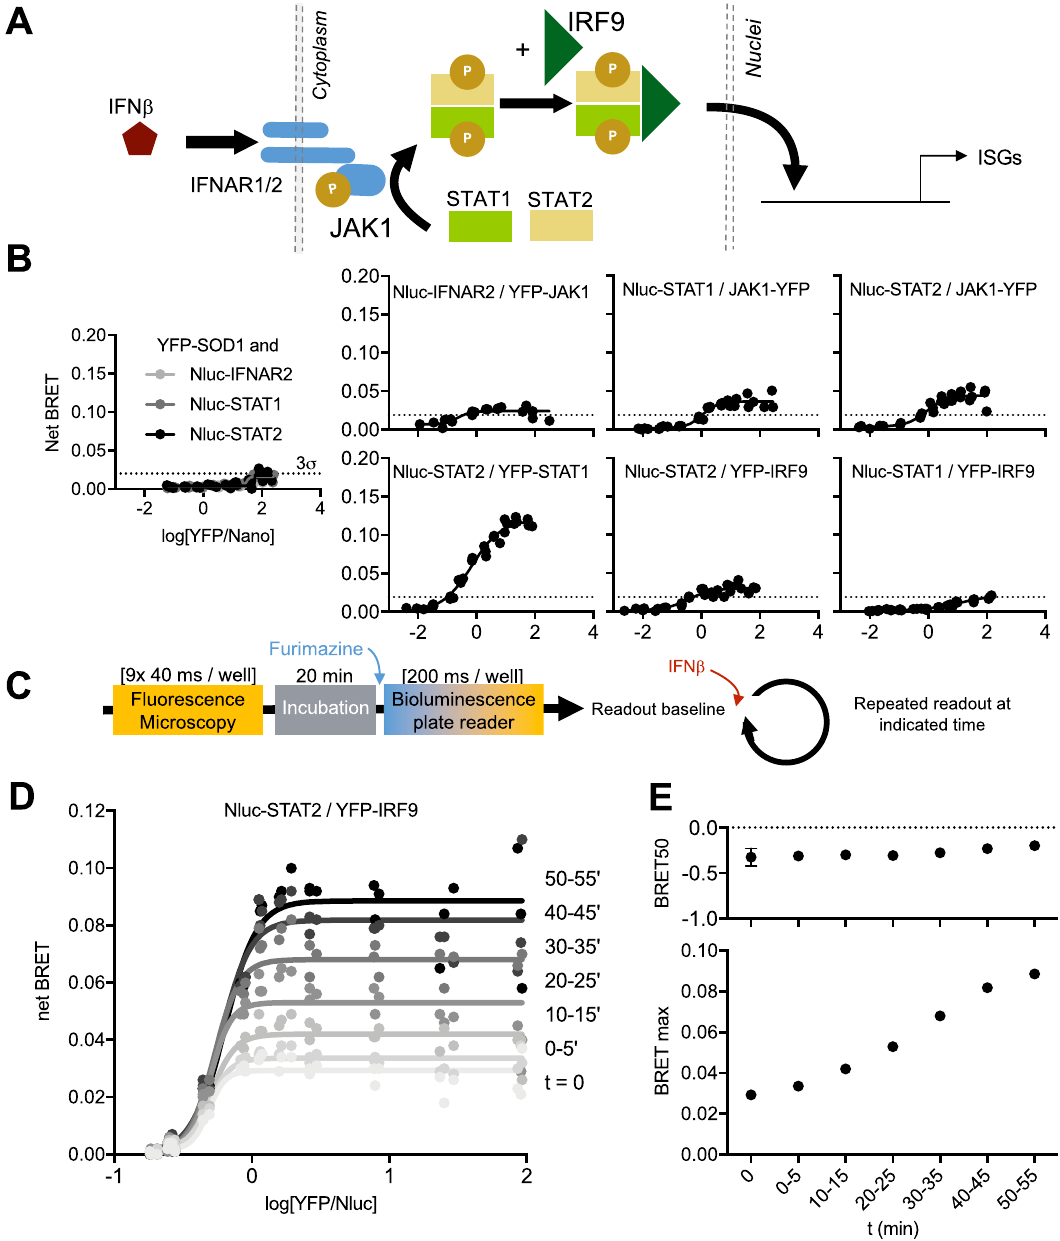
Figure 4. Study of IFN-dependent JAK/STAT pathway and time-lapse monitoring of STAT2/IRF9 interaction. ( A ) JAK/STAT signaling network. ( B ) Variable donor BRET saturation assay of Nluc- and YFP-tagged protein pairs from the JAK/STAT pathway as in Fig. 1. Based on the acceptor protein YFP-SOD1 negative control, a 3σ threshold (0.02) was defined. ( C ) Immediately after the initial bioluminescence acquisition (t = 0), IFNβ was added to the cells at 500 U/mL, and the cells were monitored every 10 min for 1 h. ( D ) Variable donor BRET saturation assay of Nluc-STAT2/YFP-IRF9 after IFNβ stimulation. ( E ) BRET50 and BRETmax were represented according to the time of